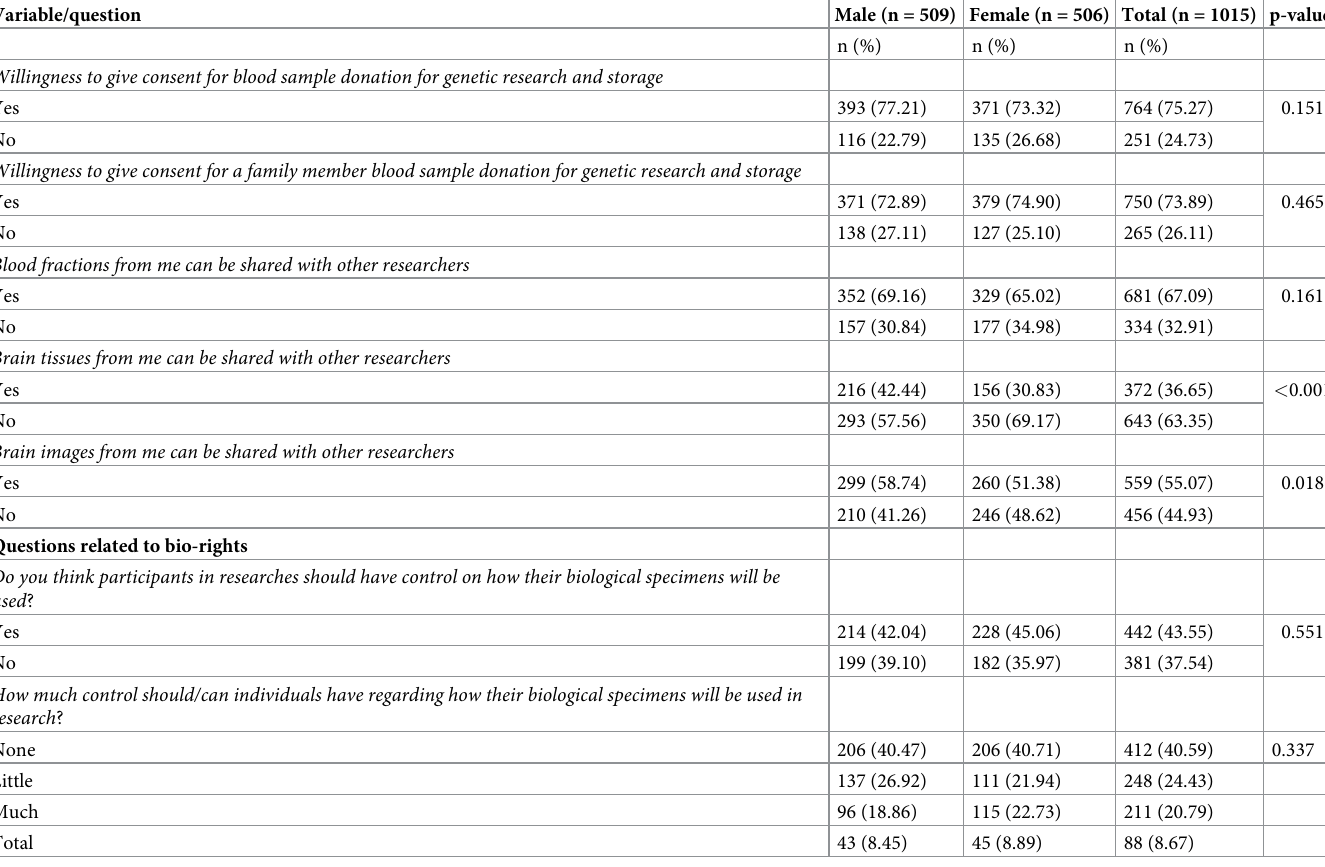
Table 4. Willingness towards blood/brain sample